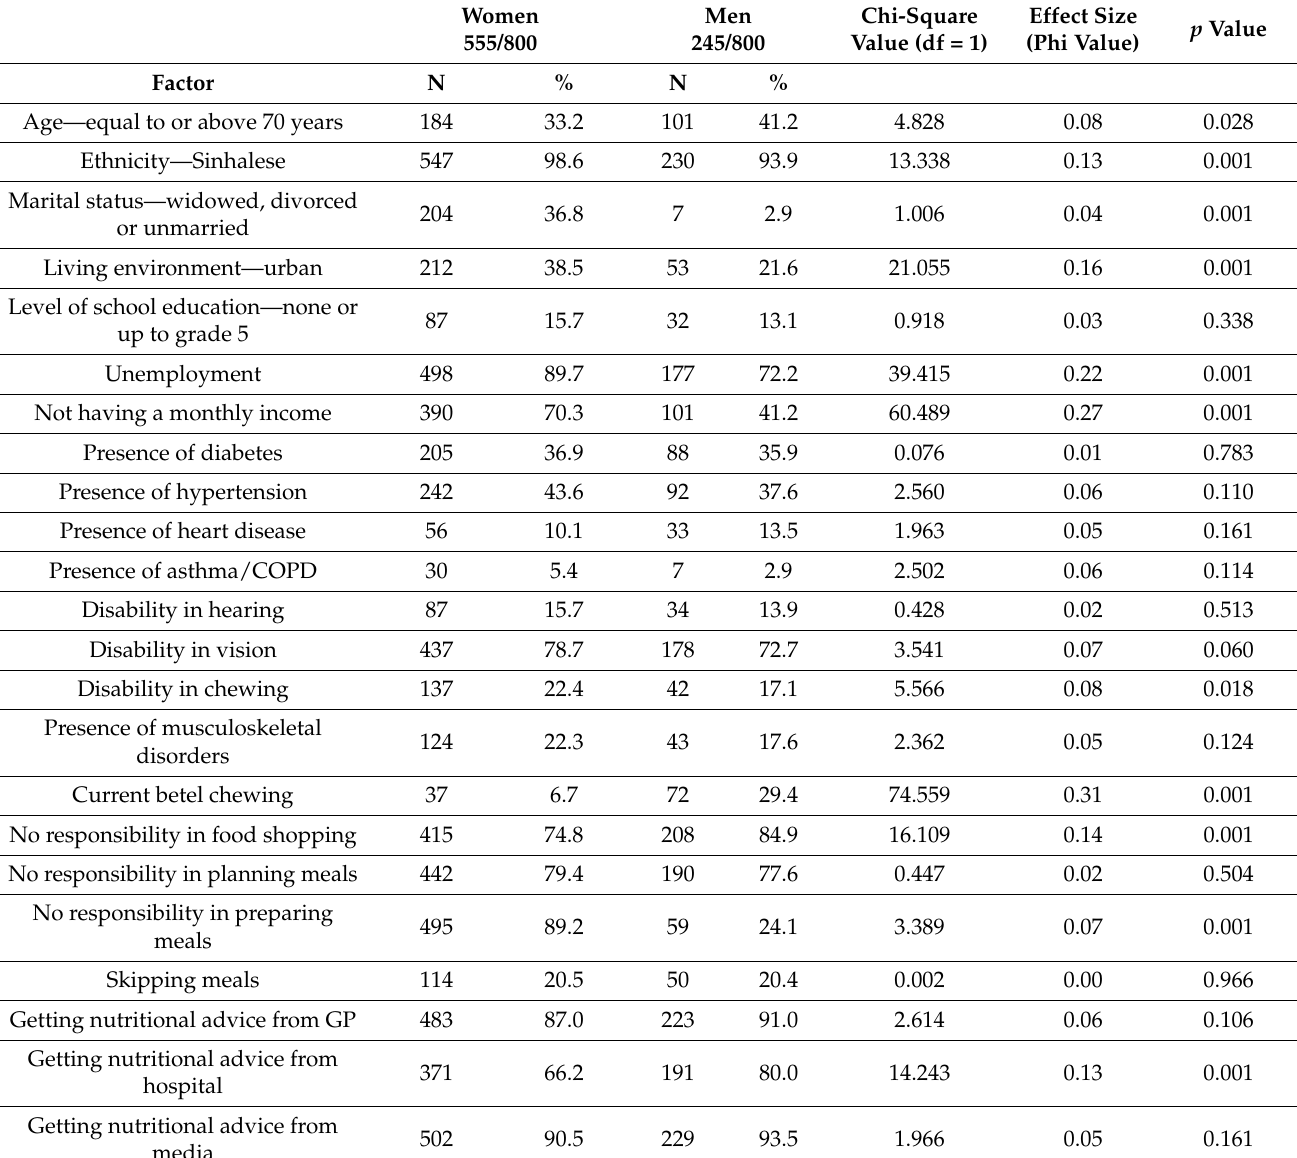
Table 1. Multiple comparison of factors among older men and women in the